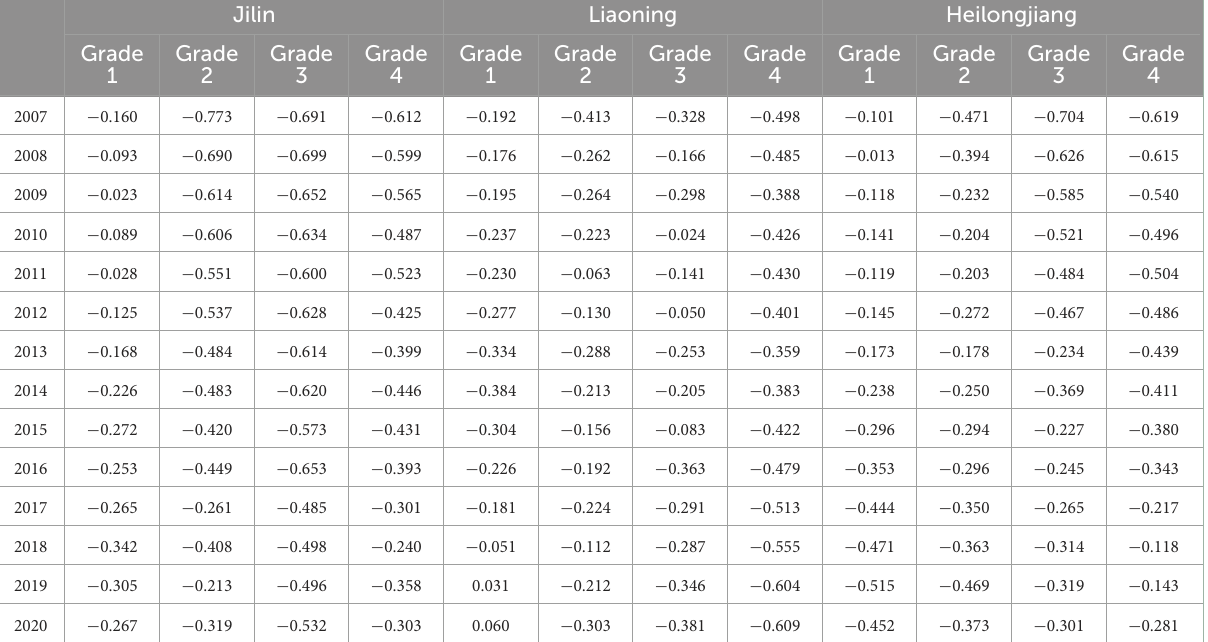
TABLE 3 Correlation of the evaluation matter-elements in the three